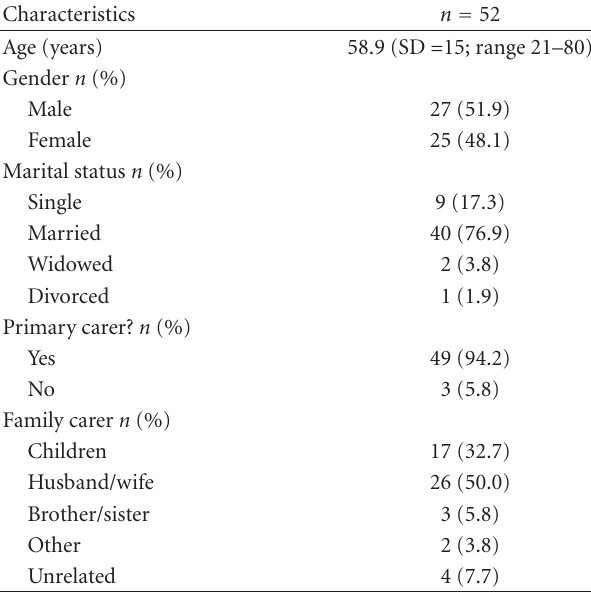
Table 2: Sociodemographic characteristics of carers.